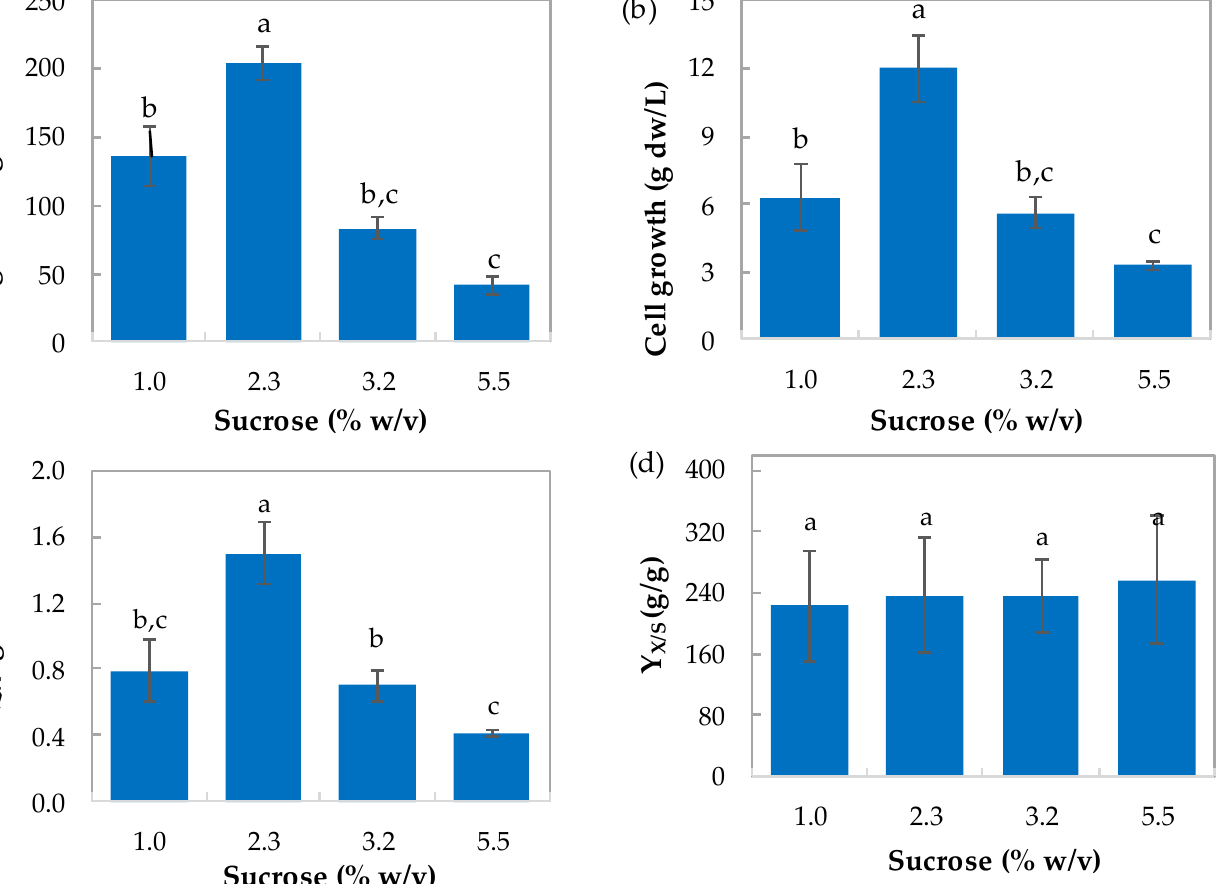
Figure 4. Cell growth parameters: ( a , b ) fresh and dry weight, ( c ) biomass yield (Y X/S ), and ( d ) productivity) (Q X ) in suspension cultures of T. officinale maintained at different sucrose concentrations (1.0, 2.3, 3.2, and 5.5% ( w / v )) (Basal MS medium, 3.0 mg/L NAA, 3.0 mg/L BAP, 20 ± 2 ◦ C, 115 rpm, 8th week of culture). Means with the same letter above the bars were not significantly different at the 0.05 level according to the DMRT test. Bars indicate standard error.